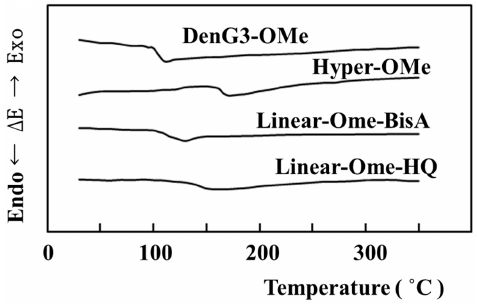
Figure 5. DSC curves of DenG3-OMe , Hyper-OMe , Linear-OMe-BisA , and Linear-OMe-HQ .